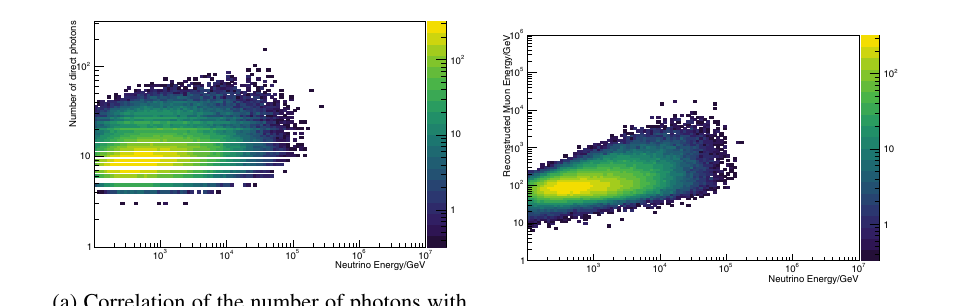
Figure 1 . Correlation of the input variables with the true energy of the neutrino for the IC-79